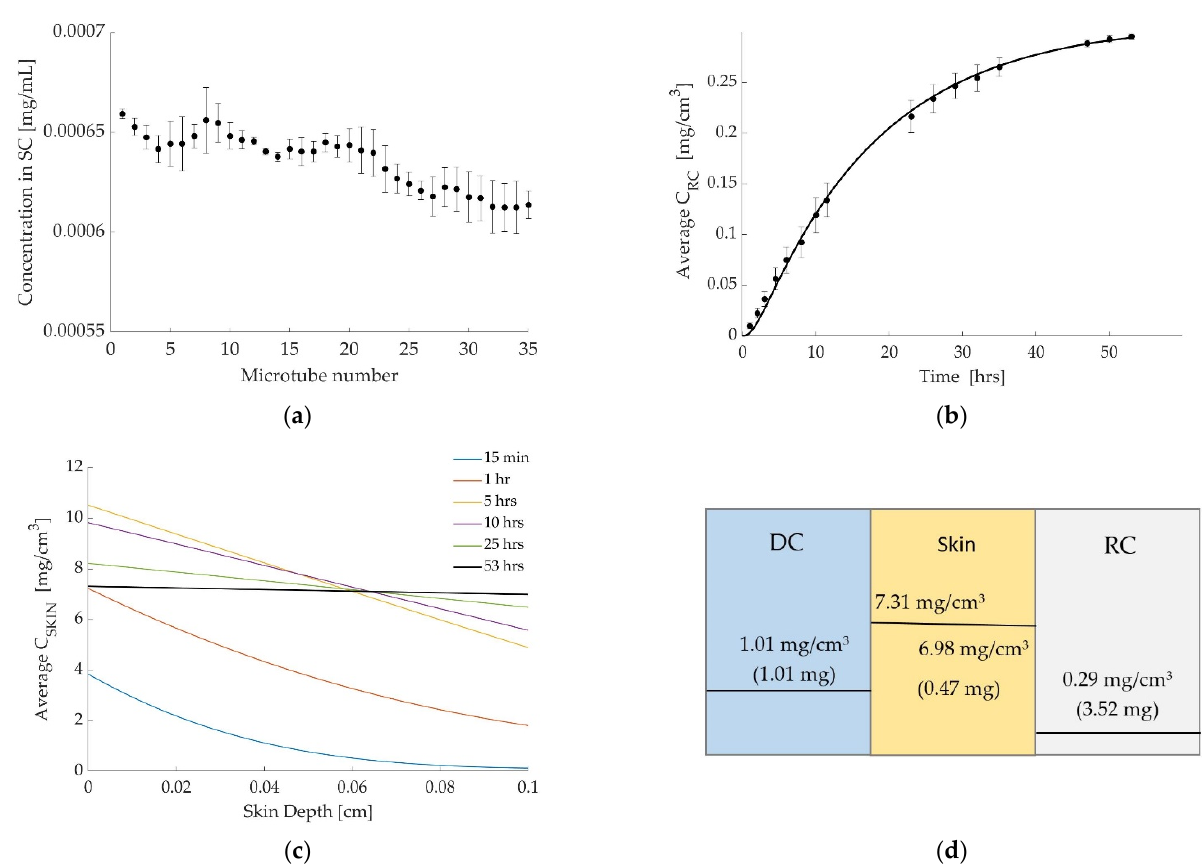
Figure 5. Caffeine at 32 °C. ( a ) Tape stripping results (mean of all replicates ± standard deviation). Microtube no. 1 represents tapes no. 1–2 in the top layer of SC and no. 35 represents tapes no. 69–70. ( b ) Simulated release curve (solid line) and experimental results (marker). ( c ) Simulated concentration profiles in the skin at different times. ( d ) The concentration and the amount of drug in each layer at the end of the simulation, showing discontinuity between